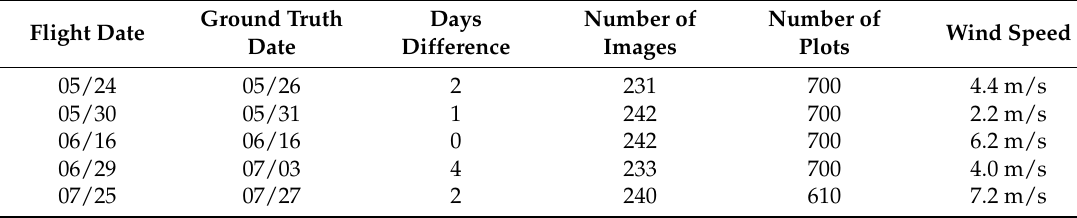
Table 1. UAV flights with corresponding field plant height measurements.